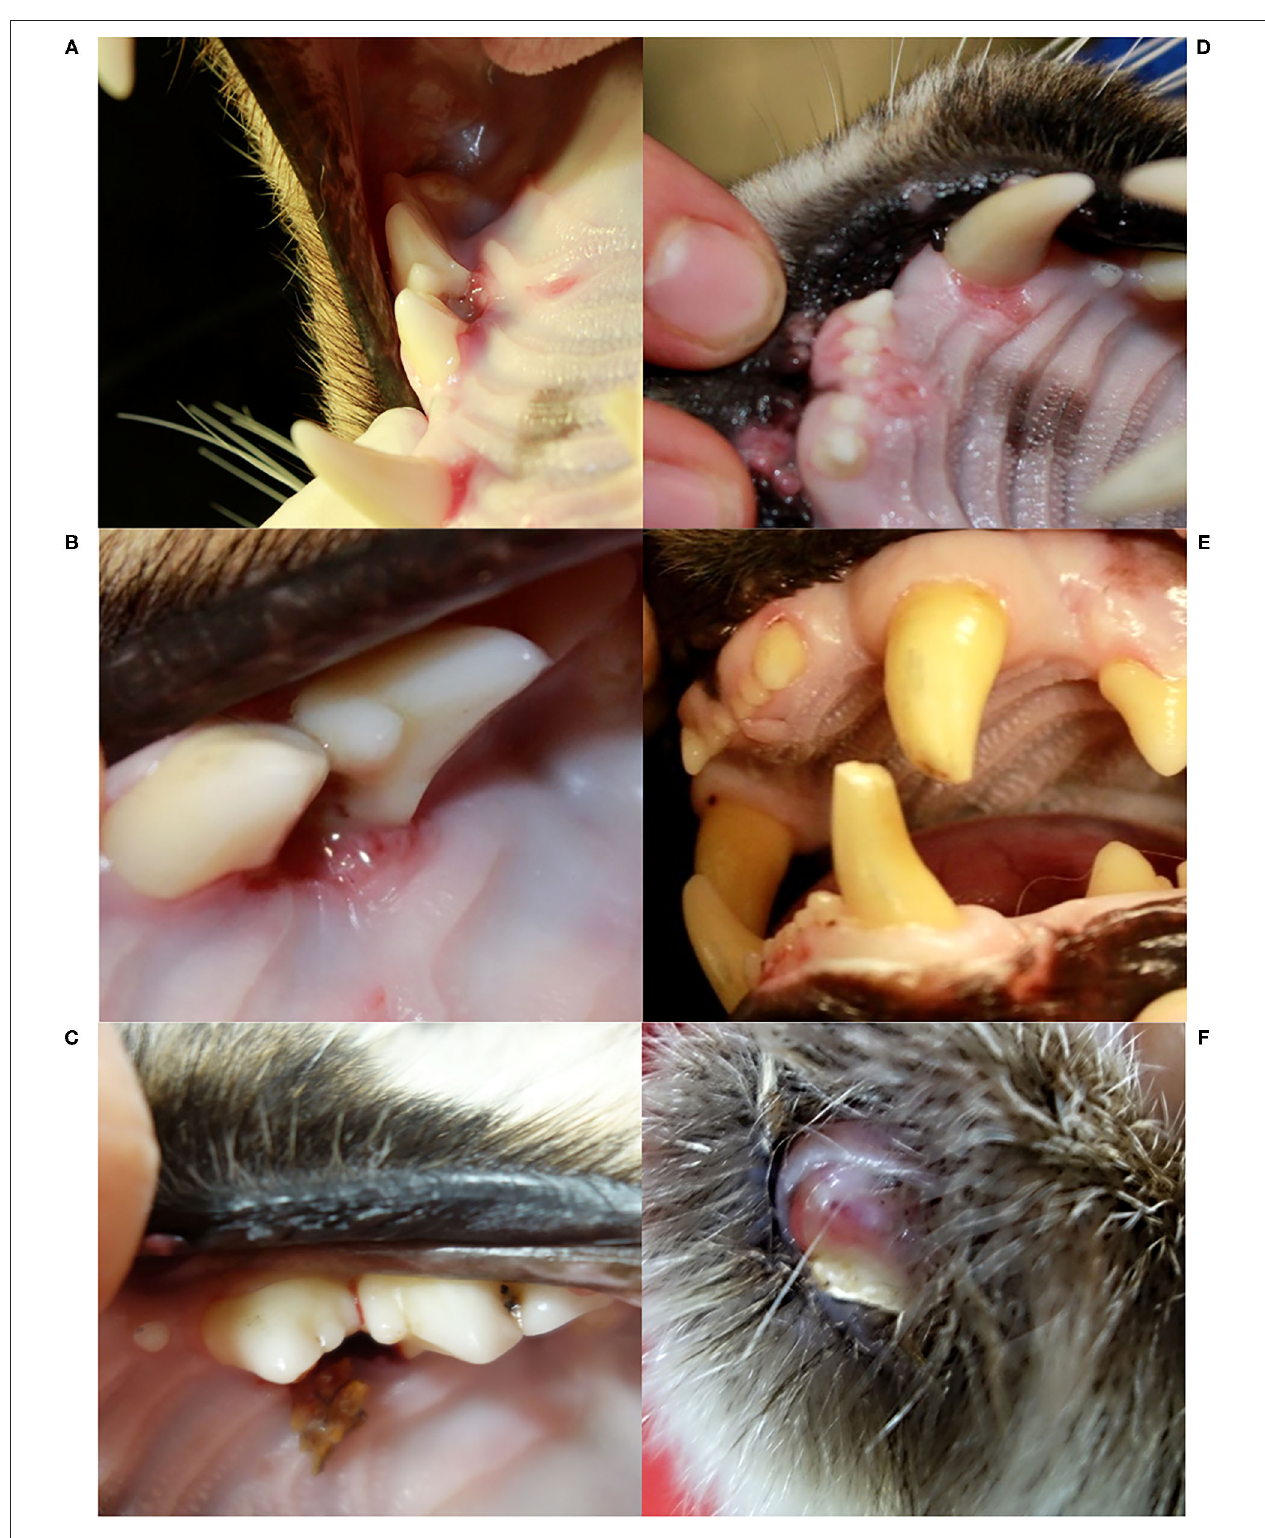
FIGURE 4 | Oral cavity (A–E) and claw (F) , Eurasian lynx ( Lynx lynx ), examination during quarantine; (A) and (B) SENI: marginal gingivitis around left maxillar teeth; (C) SENI: socket formation and intralesional wood fragment between the premolars; (D) SENI: multifocal palatal erosions at the basis of the incisors and left canine; (E) Teeth, NAIA: three fractured canines with exposure of the pulp chamber of the two left canines; (F) Claw, SENI: Worn down claw with inflammation of the surrounding soft tissue.